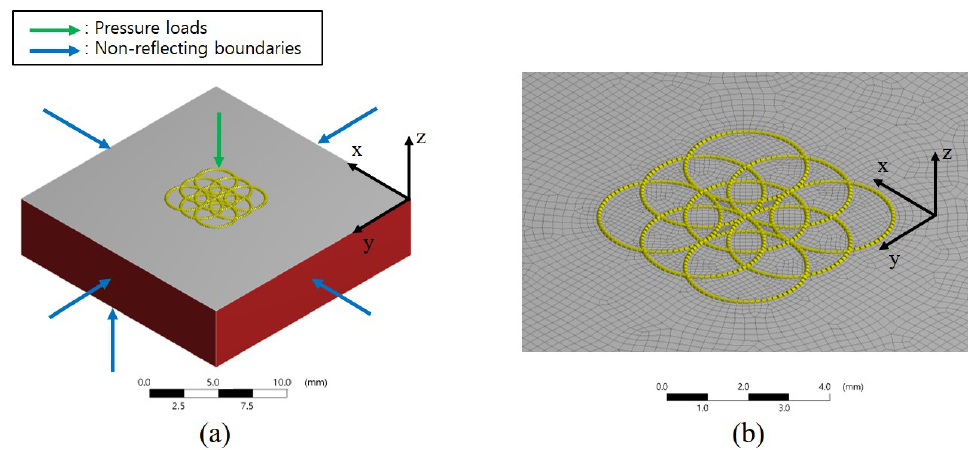
Figure 5. FE model setup; ( a ) Pressure load and boundary condition faces; ( b ) Edge sizing for fine mesh generation.